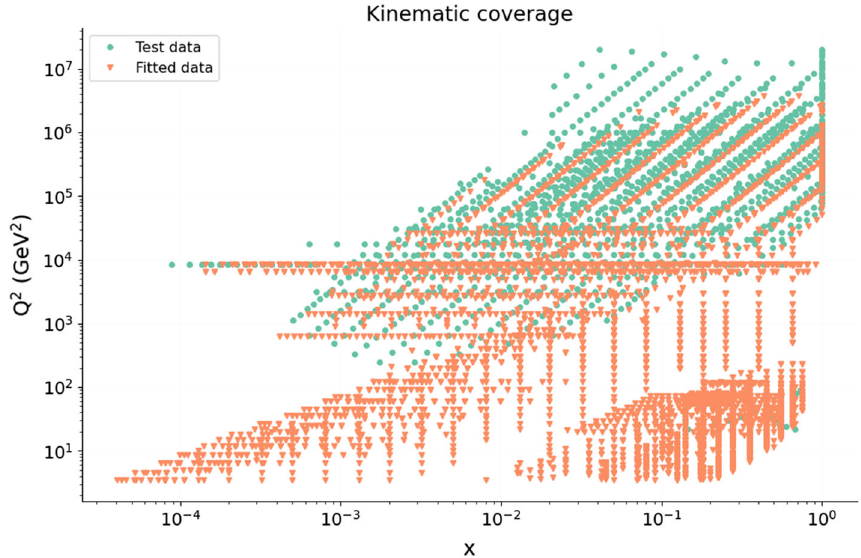
Fig. 9 The kinematic